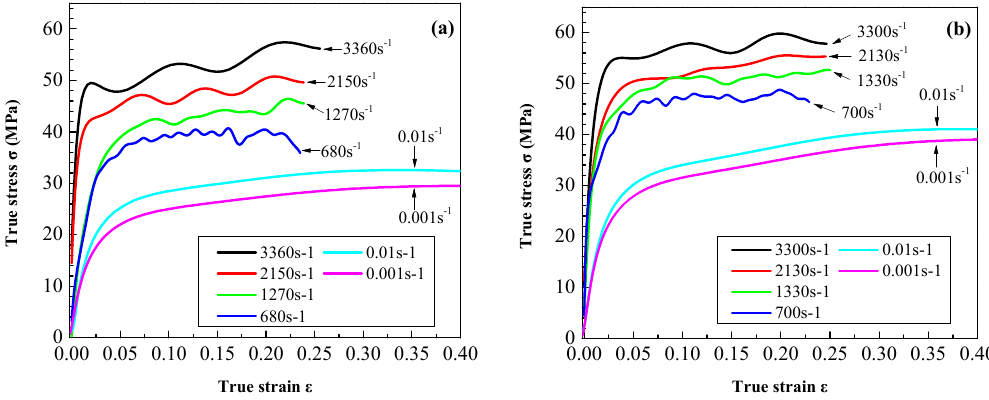
Figure 11. Typical compressive true stress-strain curves of ( a ) LDPE and ( b ) UHMWPE under a wide range of strain-rates.